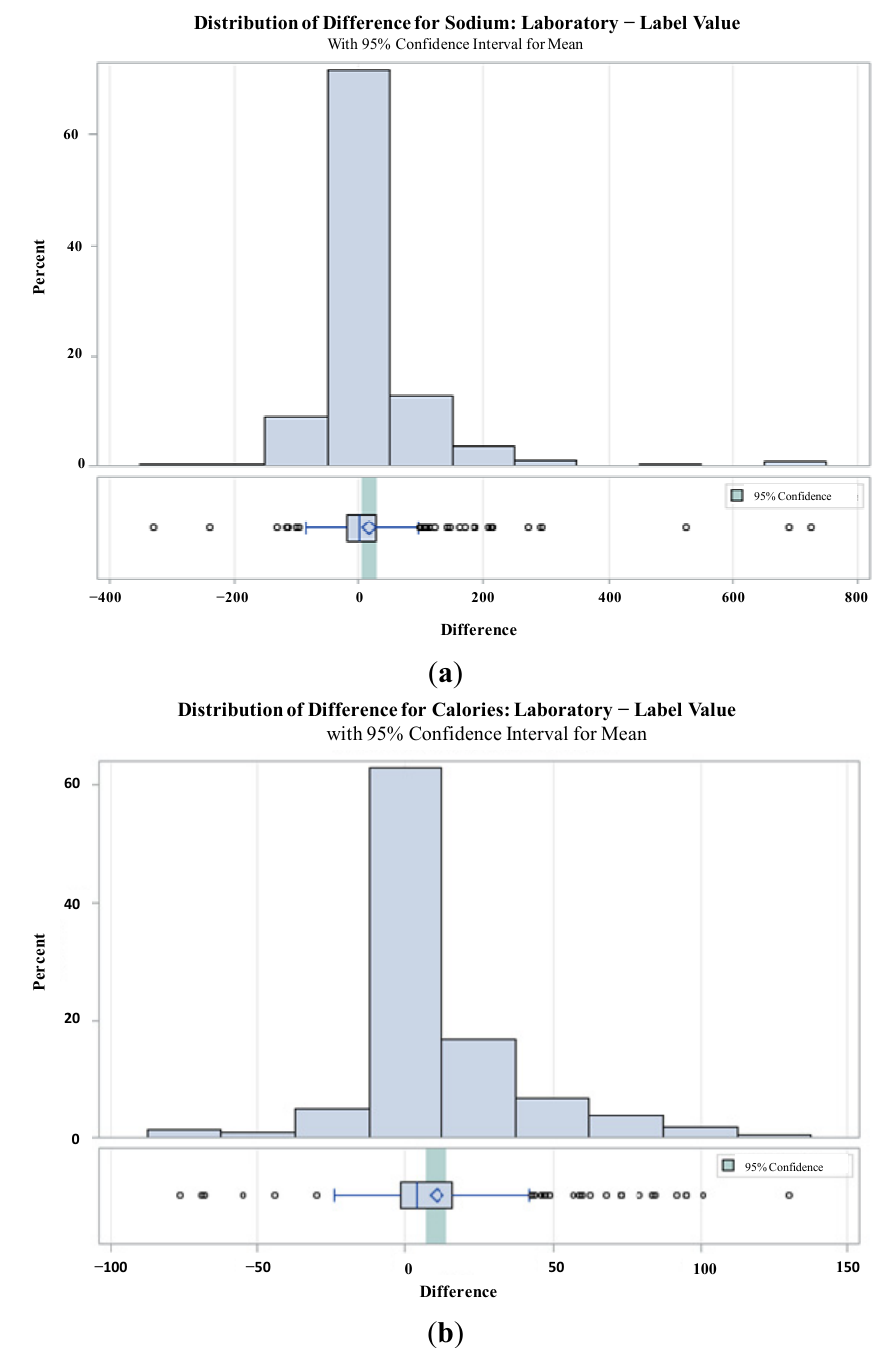
Figure 1. Distribution of differences (laboratory value − label value) for ( a ) sodium and ( b ) calories.